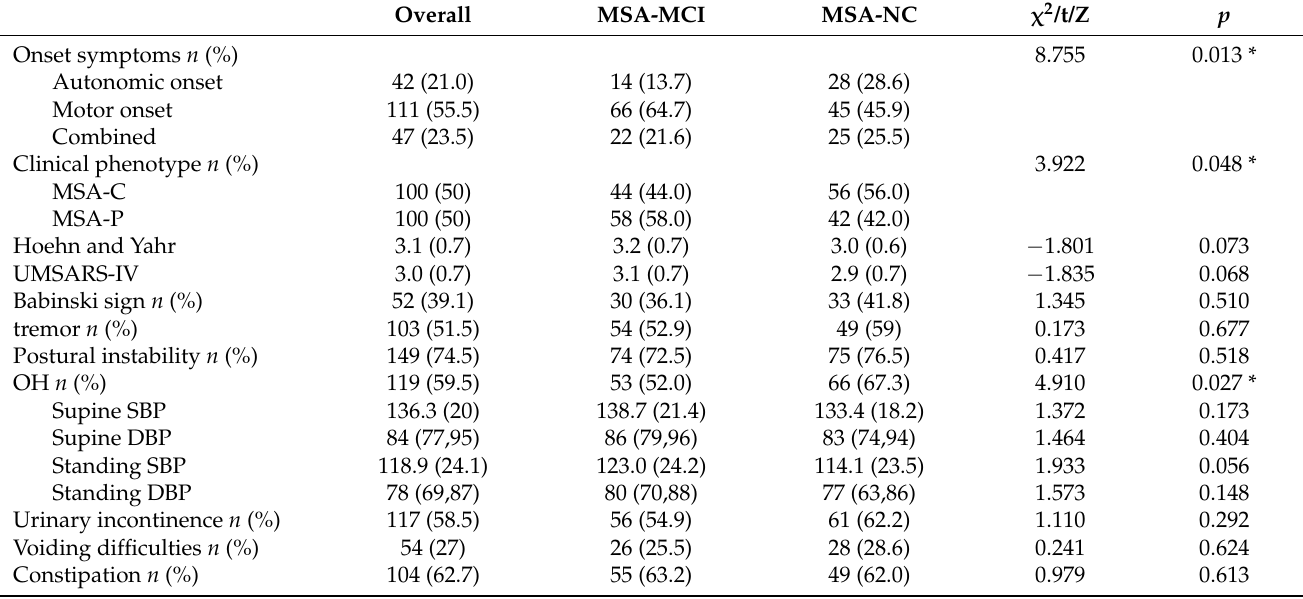
Table 2. Clinical features in MSA